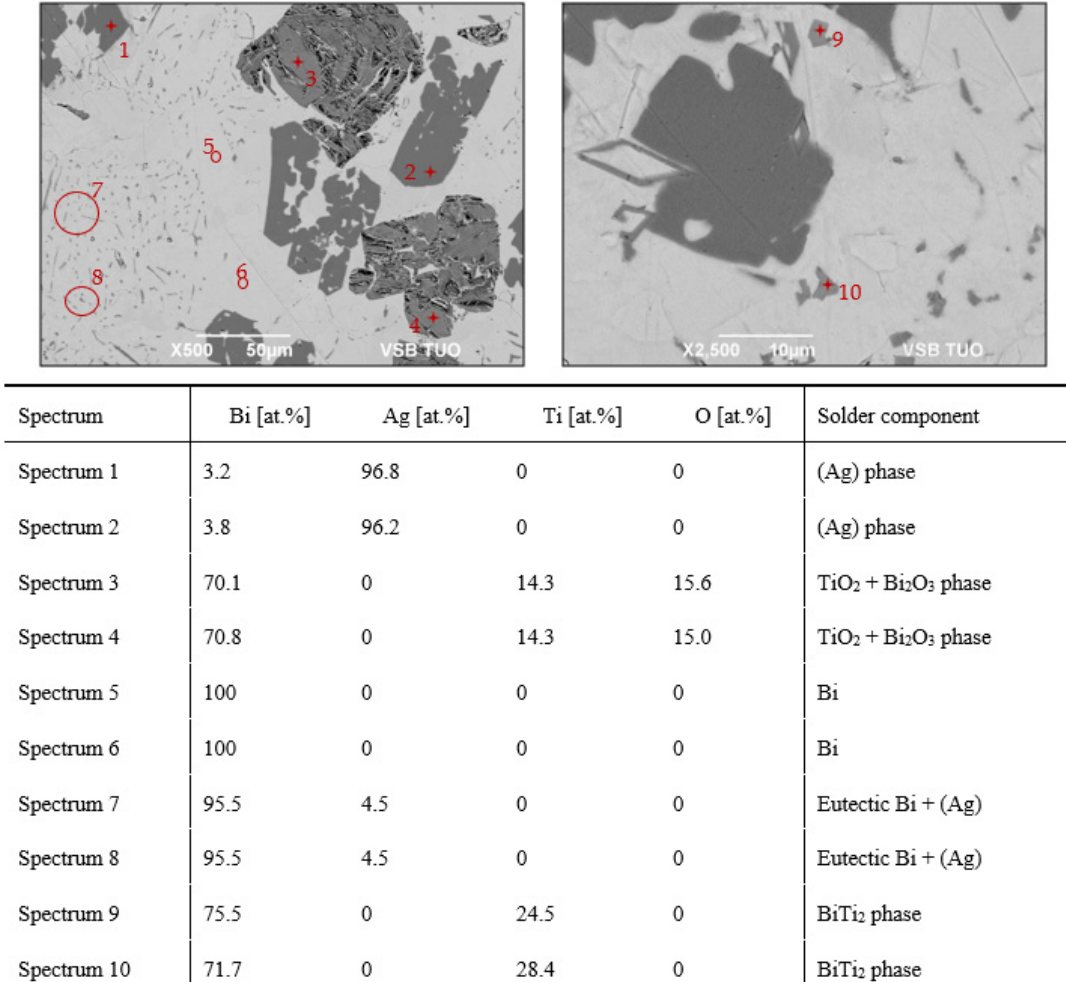
Figure 8. Point EDX analysis of Bi11Ag1.5Ti solder.